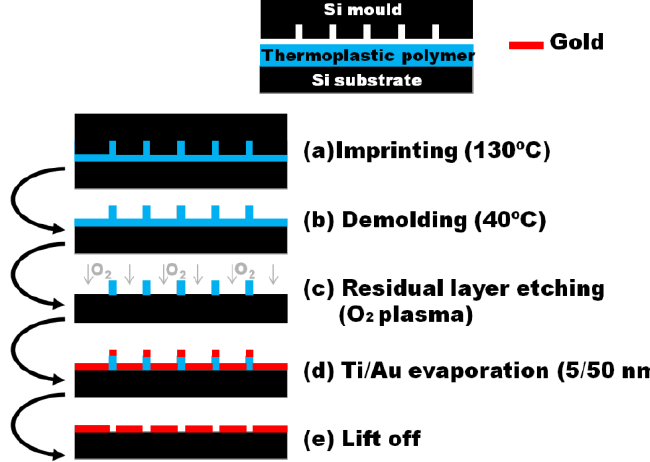
Figure 1. Schematic cross-section of the gold nanohole array fabrication process with